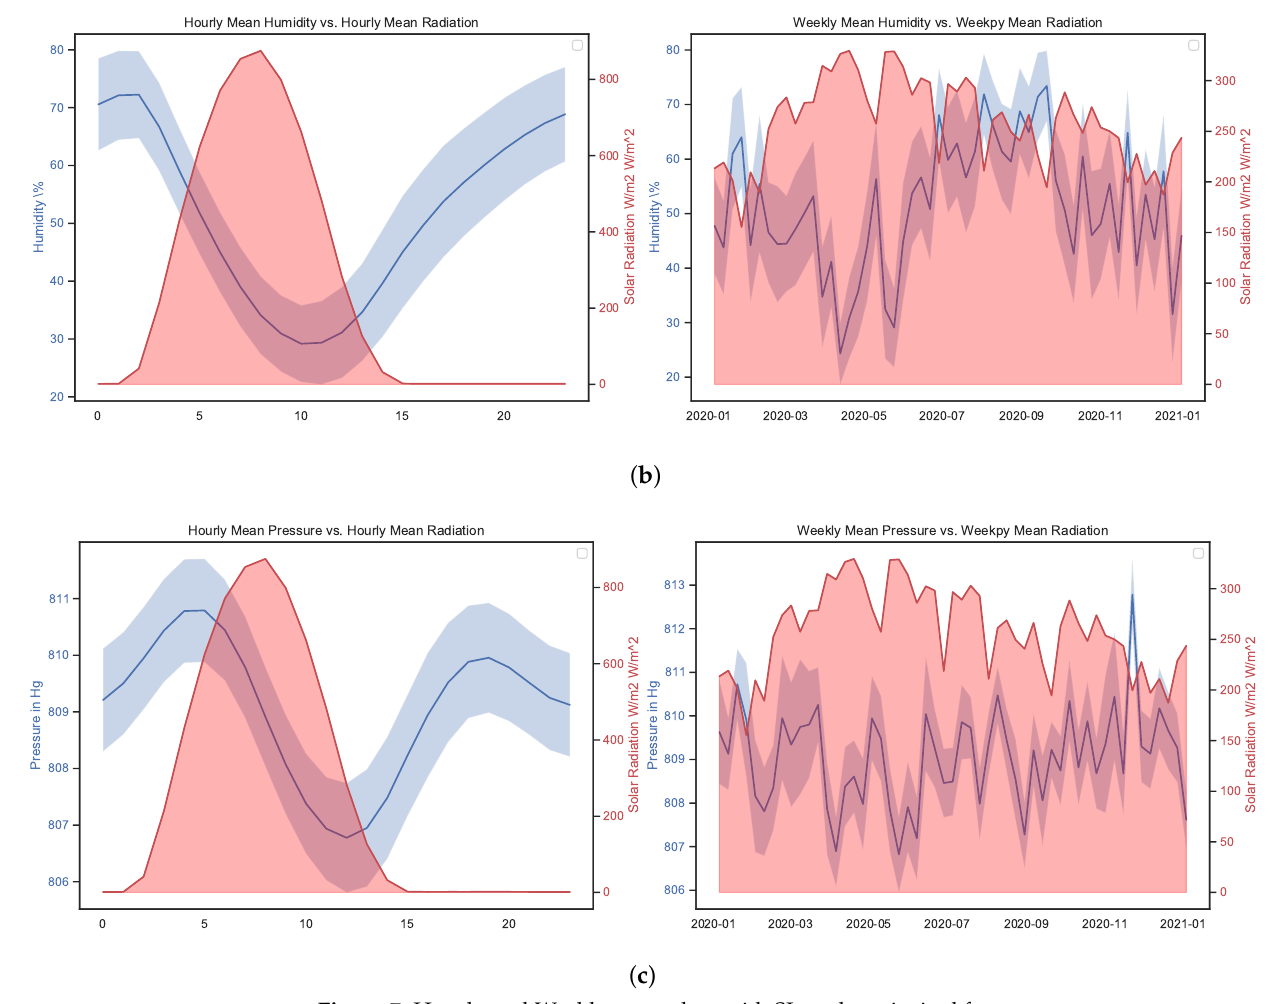
Figure 7. Hourly and Weekly mean data with SL as the principal